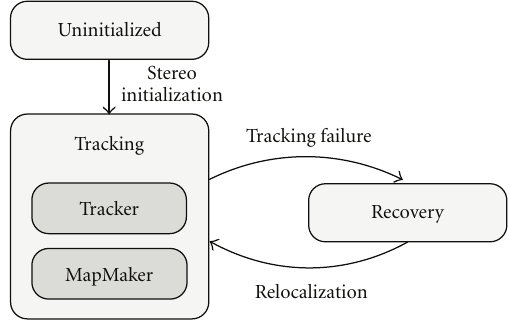
Figure 1: Major parts of